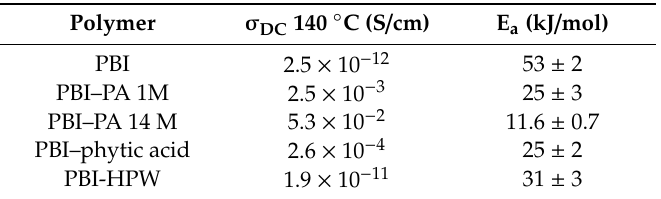
Table 3. Proton conduction activation energy calculated by PBI doped with di ff erent acids. HPW, phosphotungstic